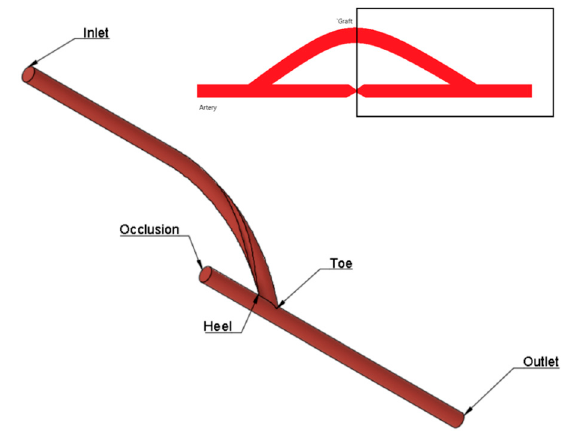
Figure 1. Conceptualized geometric model for CFD simulation.